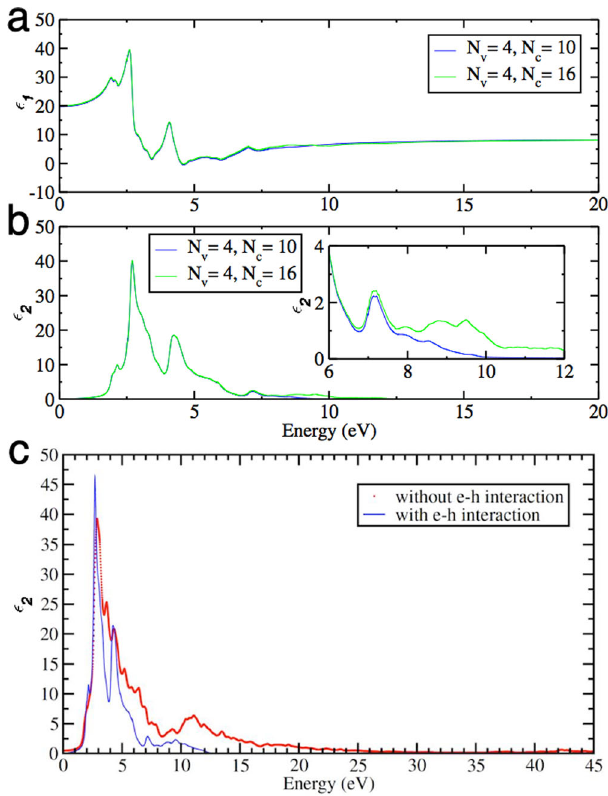
Fig. 5 High-energy dielectric function calculations. The a real and b imaginary parts of the complex dielectric function calculated with four valence bands and 10 (blue) and 16 (green) conduction bands. c Calculations of the imaginary part of the complex dielectric function with and without electron – hole